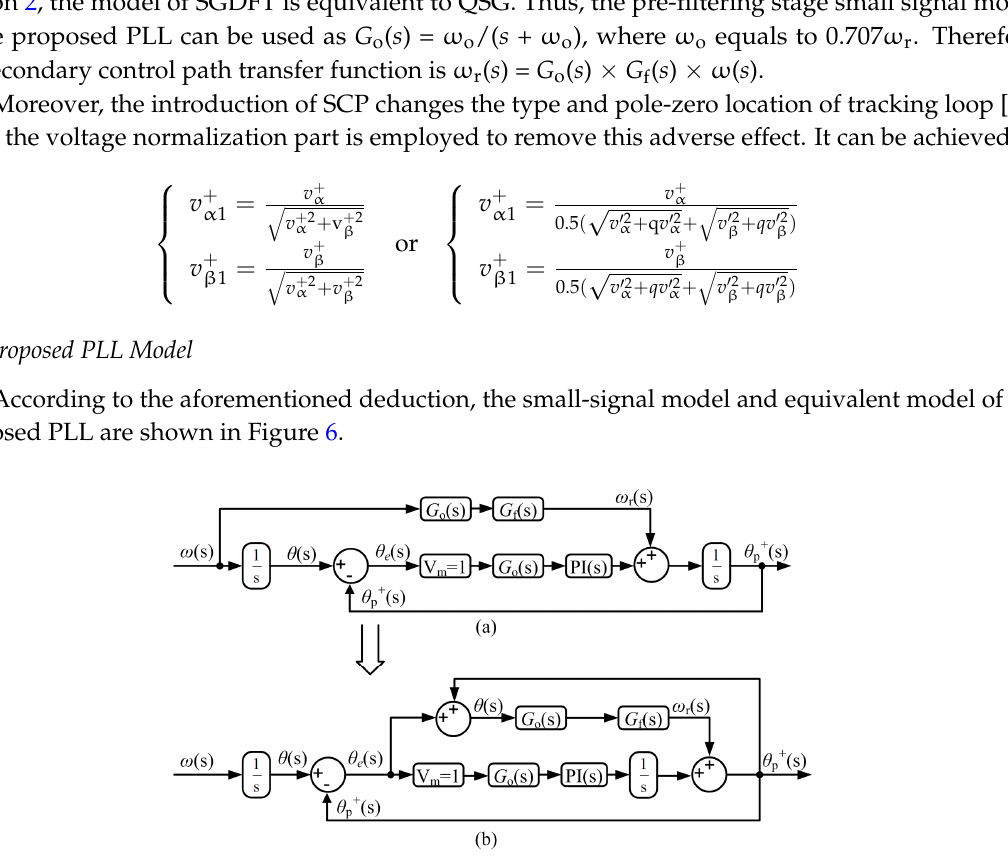
Figure 6. Small-signal model of the proposed PLL. ( a ) Original model; ( b ) Equivalent model.